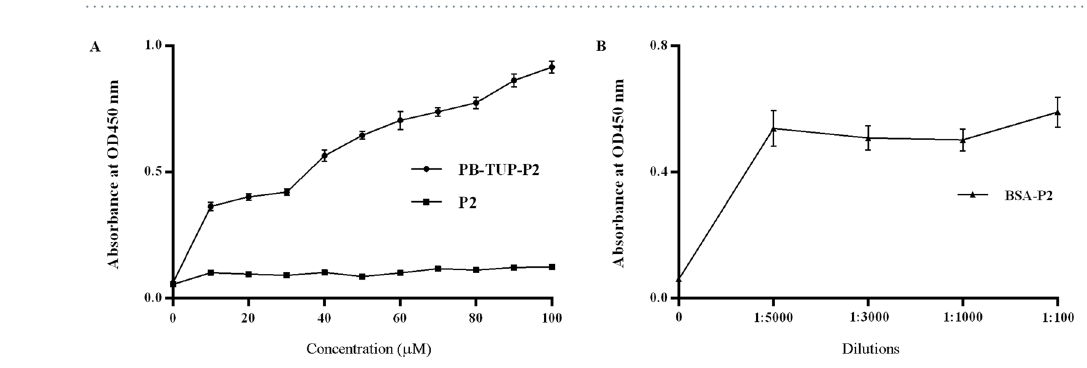
Table 1. Peptide sequence of P2 and the appended sequence with an N-terminal PB-TUP sequence.